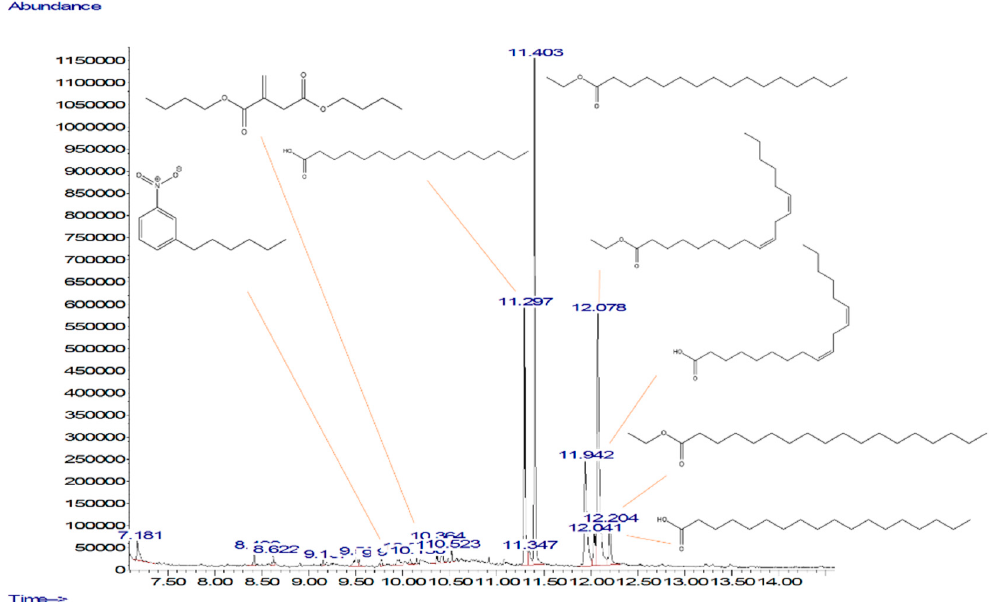
Figure A2. GC-MS chromatogram obtained from MEW–SCG.